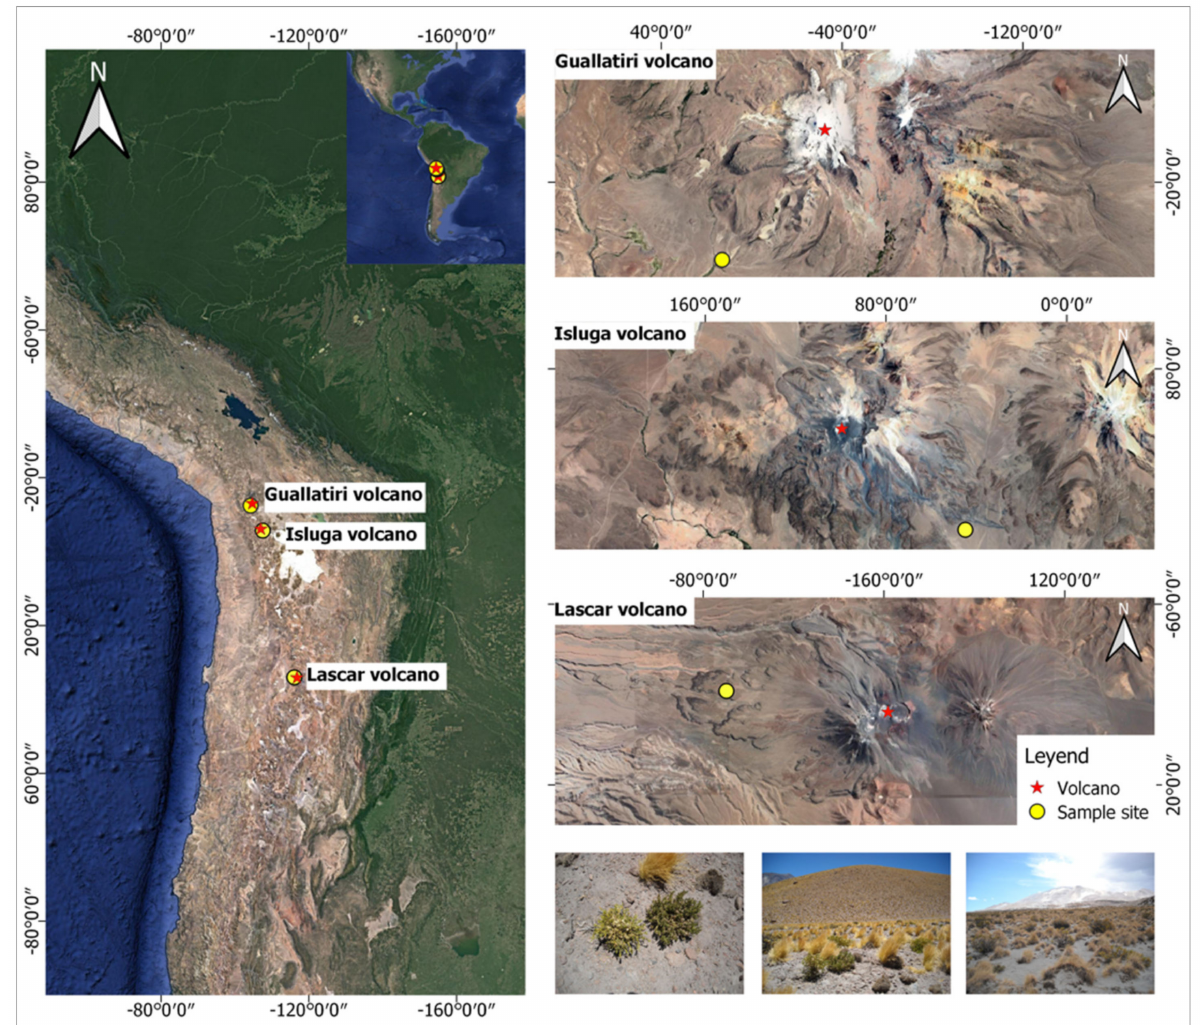
Figure 1. Map of Central Volcanic Zone of the Chilean Altiplano showing the location of sample sites. Map was taken using Google Maps (Map data: Google, Maxar Technologies), volcanoes and sampling sites are shown with red and yellow markers,